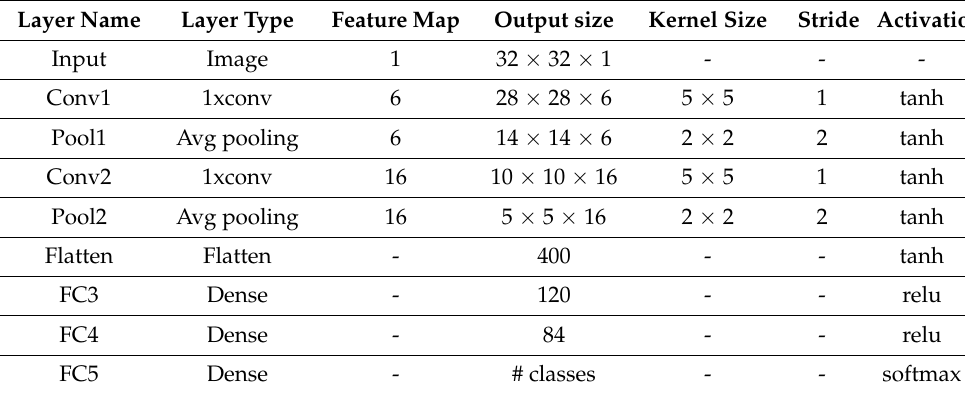
Table 1. Specifications of Lenet5 architecture.